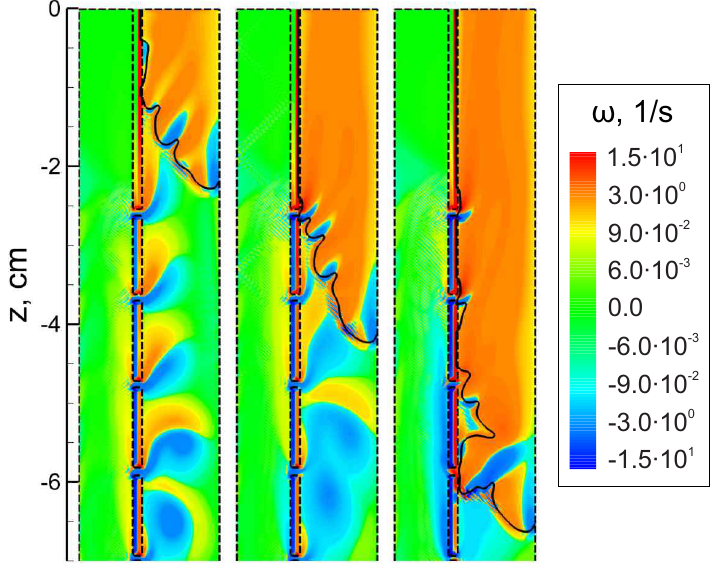
Figure 4. Calculated vorticity field in the coaxial burner at subsequent time instants (from left to right: at 70 ms, 120 ms and 170 ms after ignition). Vorticity is defined as ω = ∂ u y / ∂ x − ∂ u x / ∂ y . Solid lines—flame front, dashed lines—boundaries of the calculation domain. z = 0 corresponds to the upper exit of the